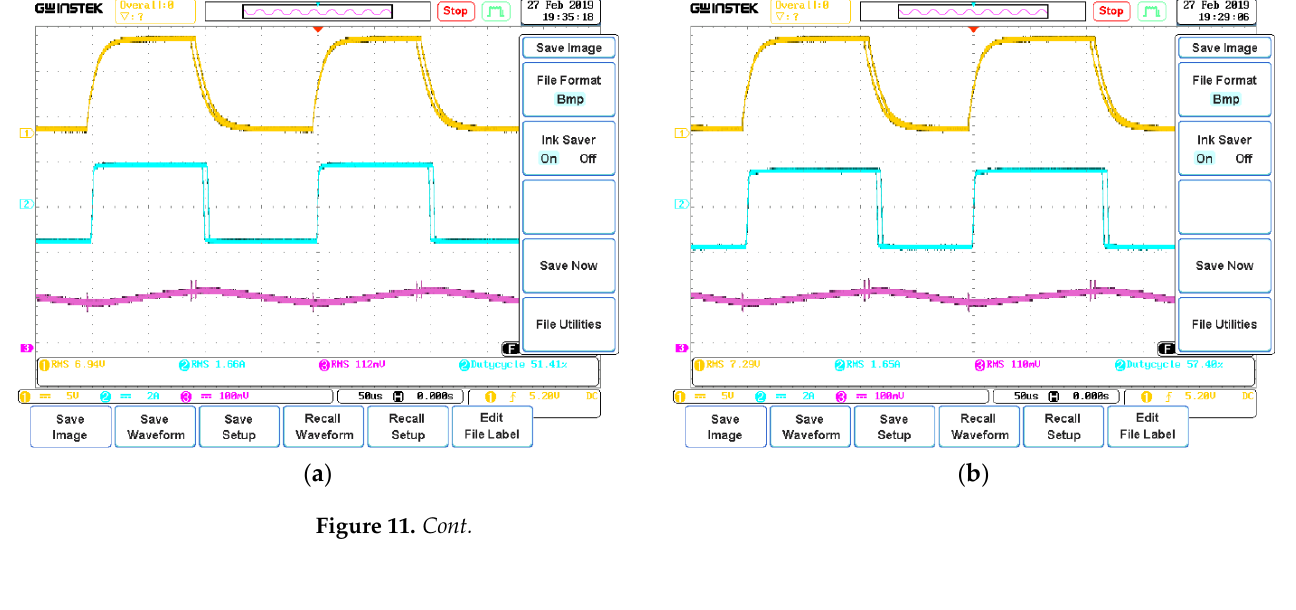
( c ) Figure 11. Waveforms of voltage V GS , drain current I D , sensor voltage E 1 of the system with XML2 power LED at E zew = 200 lx ( a ), E zew = 100 lx ( b ) and E zew = 0 ( c ). Figure 12 shows voltage and current waveforms in the system with the Ring XRE module, with the set point source illuminance E zad = 750 lx and external illuminance E zew equal to 200 lx (a) or 100 lx (b), respectively. The convention for determining the appro ‐ priate waveforms is the same as in Figure 11.